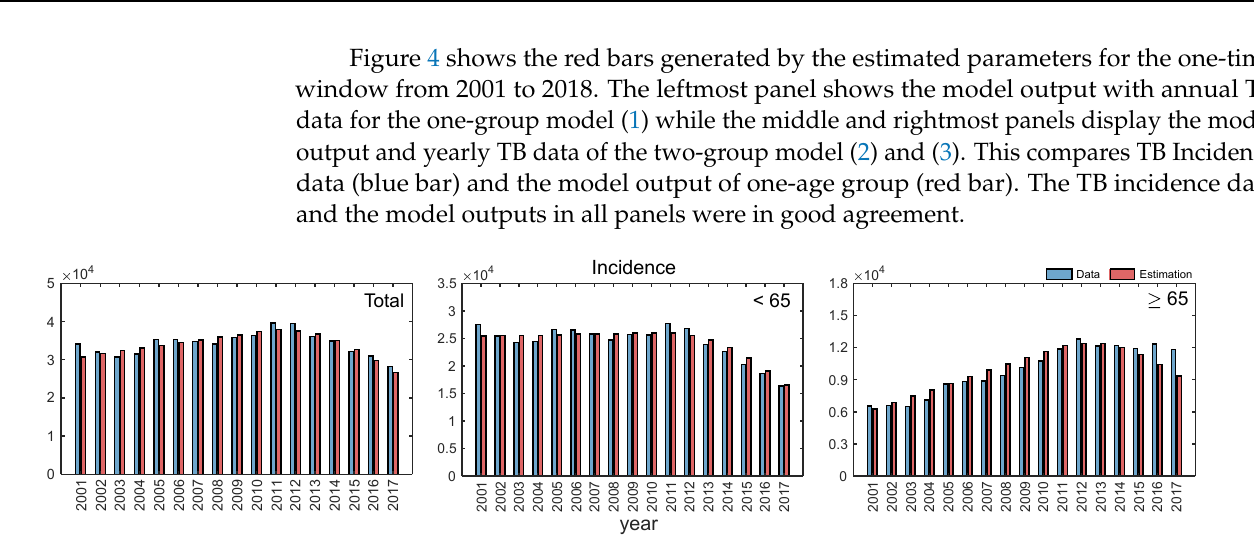
Figure 4. Model parameters were estimated in one period of 2001 to 2018. The leftmost panel showed TB Incidence data (blue bar) and the model output of the one-age group (red bar). Non-elderly TB incidence of the 2-age group is compared in the middle panel (blue for data and red for model output). Elderly TB incidence data (blue bar) and the model output of the 2-age group (red bar) are compared in the rightmost panel.